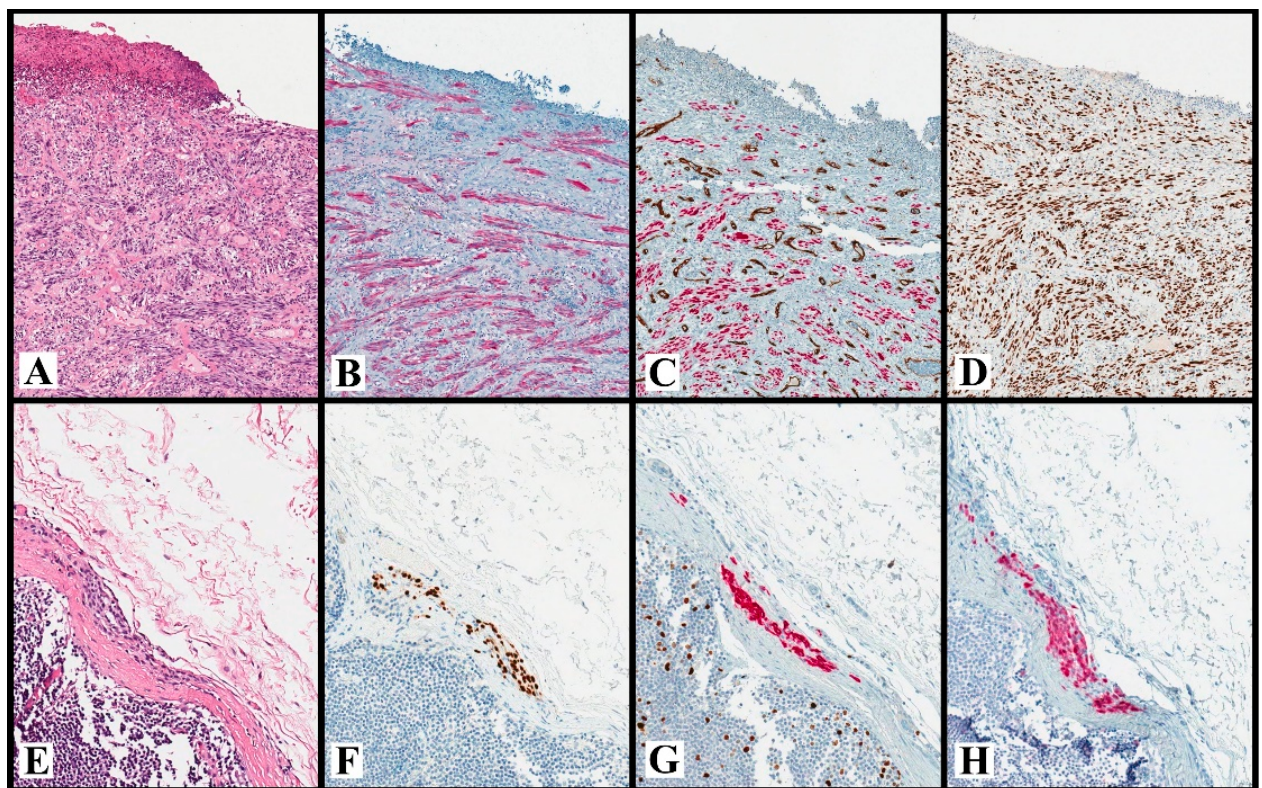
Figure 1. Desmoplastic cM ( A – D ). A case of ulcerated desmoplastic cM with marked desmoplasia, atypical spindle cells, and rare mitoses (( A ): H&E, original magnification × 100). This case turns out positive for SOX10 (( B ): CD34/SOX10, original magnification × 100; CD34: brown, SOX10: red), S100